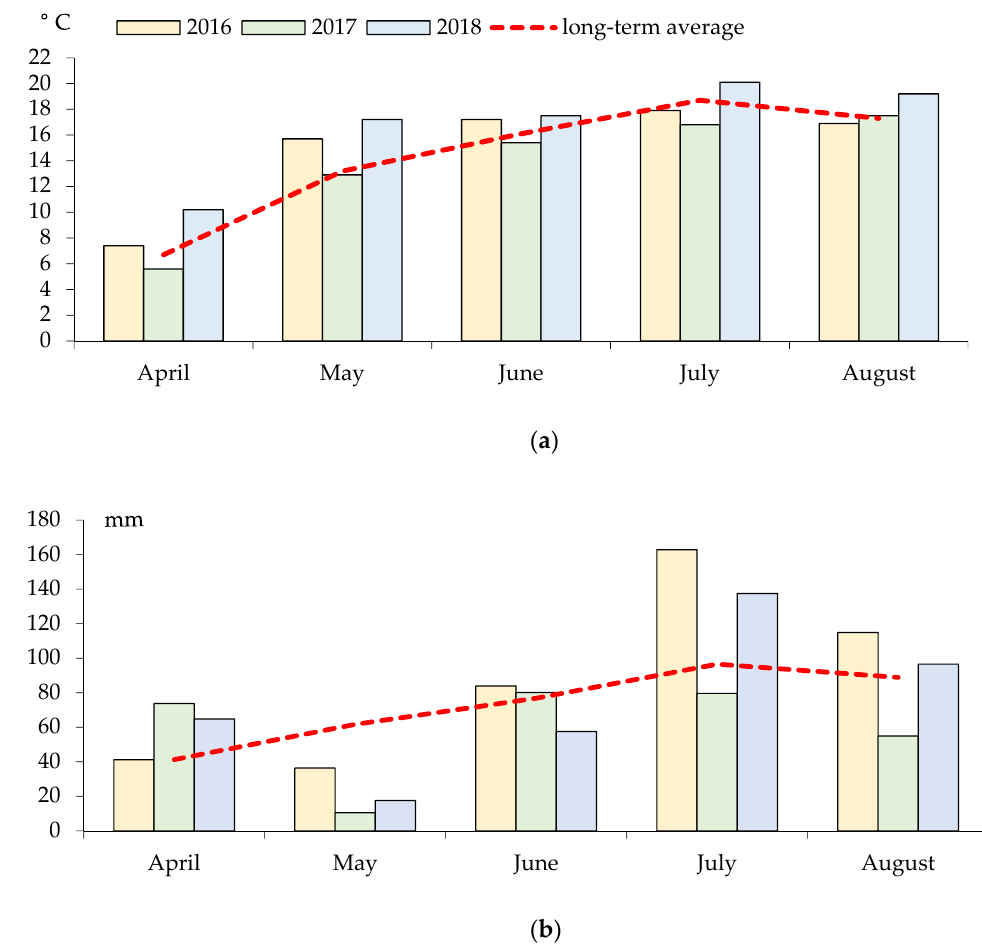
Figure 1. Average air temperature ( a ) and precipitation rate ( b ) during faba bean growing seasons at the Kaunas Meteorological Station in 2016–2018.